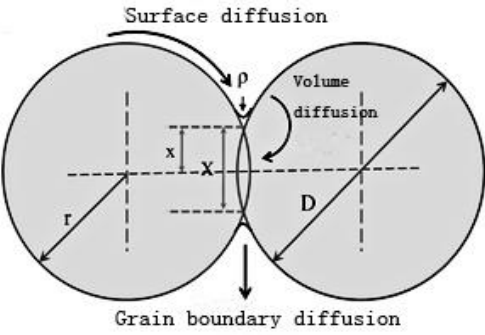
Figure 1. Schematic diagram of the sphere-to-sphere model. Reproduced with permission from [49]. In order to investigate the dominant sintering mechanism of nanosilver particles, the relationship between neck diameter and time is established. Figure 2 shows the experimental logarithm plots of the evolution of the interparticle neck size ratio x / r at different temperatures. The mechanism-characteristic exponent (the values of inverse slope) at the sintering temperatures of 160, 200, and 250 °C are 6.7, 8.8, and 8.4, respectively (the mean value is 7.9). These results indicate that surface diffusion may be the dominant diffusion mechanism at the sintering temperature range of 160–250 °C. When the sintering temperatures increase to 300–350 °C, volume diffusion is probably the prevailing diffusion mechanism [51].